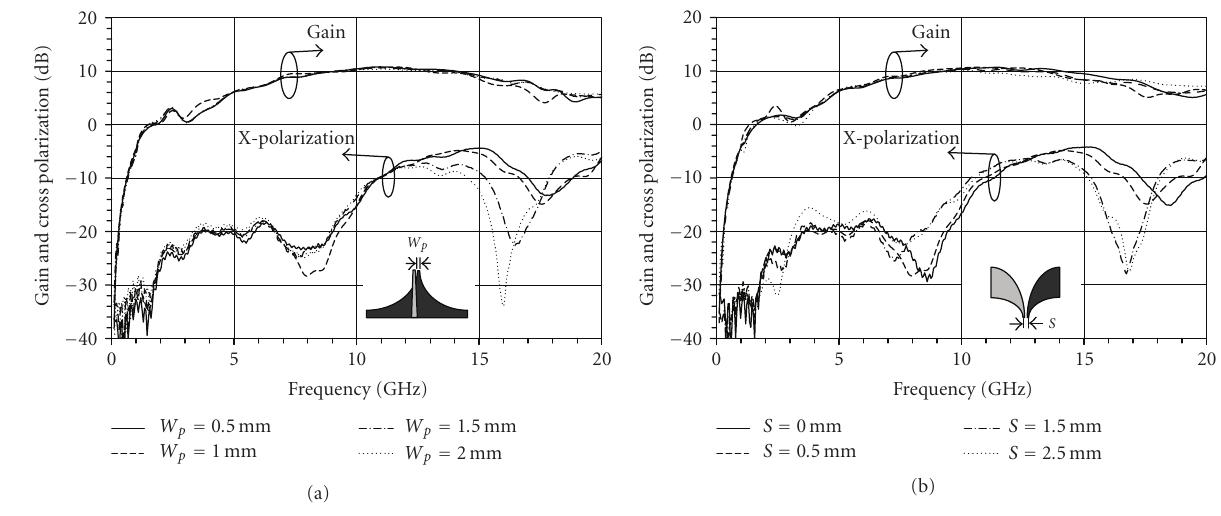
Figure 9: Gain and cross-polarization levels for parallel strip lines.